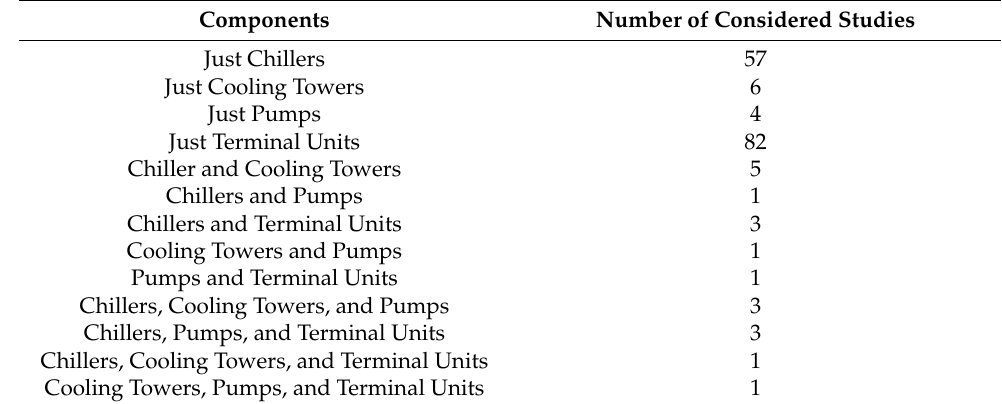
Table 3. Breakdown of considered studies.